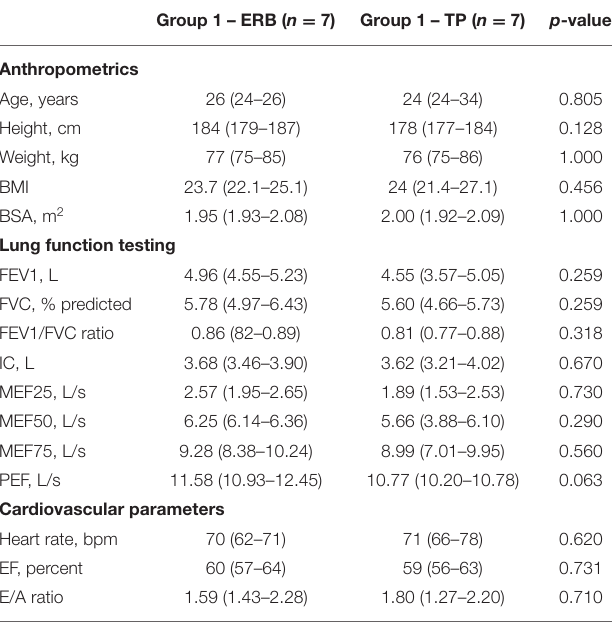
TABLE 1 | Baseline characteristics of study participants starting with expiratory resistance breathing (ERB, group 1) and tachypnea (TP, group 2).